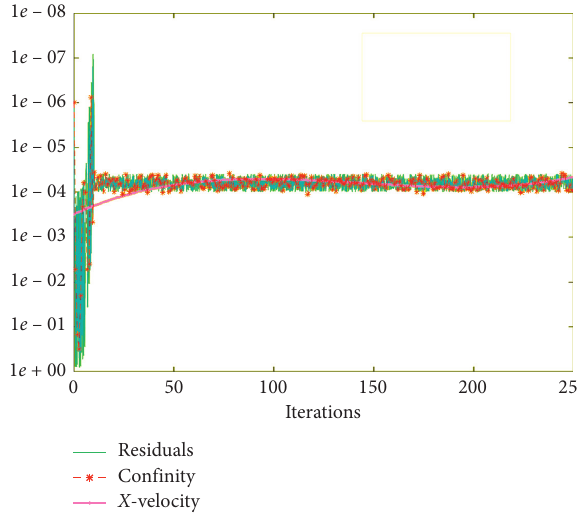
Figure 3: Simulation calculation residual Table 2: Statistics of lift coefficient of wave impact height.